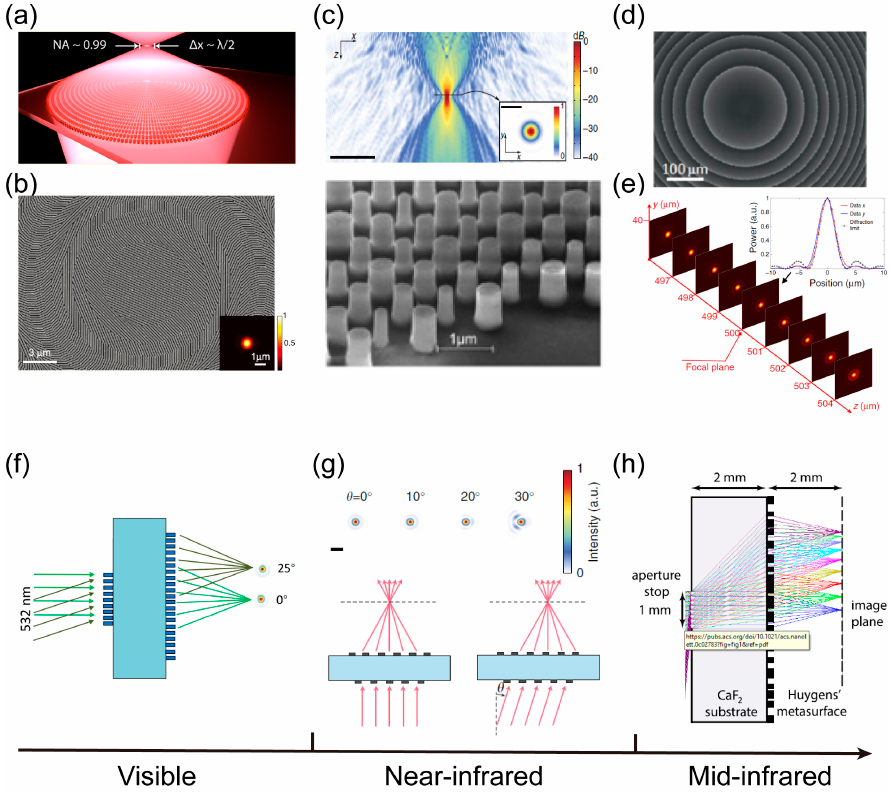
Figure 5. Metalenses used for monochromatic aberration correction. ( a ) Metalens with high numerical aperture (NA ≈ 1) [172]. ( b ) Geometric phase-based metalens with high focusing efficiency [47]. ( c ) Near-infrared polarization-insensitive metalens [173]. ( d ) Polarization-insensitive metalens with high contrast metasurface [177]. ( e ) Ultra-thin metalens via Huygens metasurface, and the focal spot profile evolution along the optical axis at 5200 nm wavelength [174]. ( f – h ) Wide field-of- view monochromatic aberration-corrected metalenses in the ( f ) visible wavelength [175], ( g ) near- infrared [176], and ( h ) mid-wavelength infrared